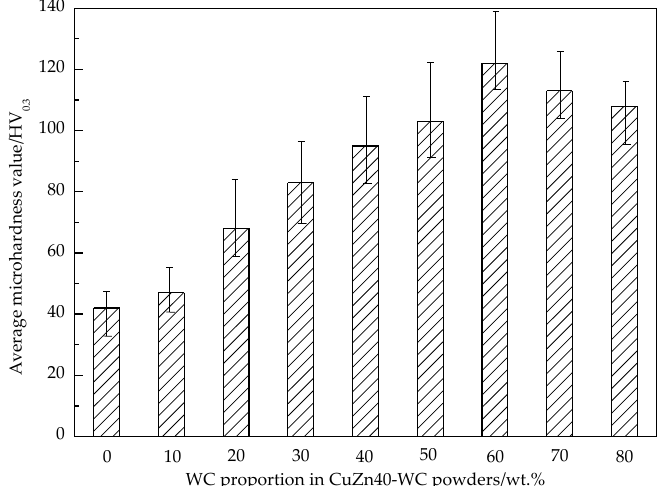
Figure 12. Effect of WC proportion on the average microhardness values of cladding layers.